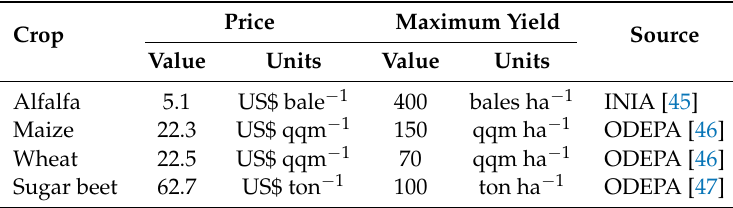
Table 2. Price and maximum yield for each